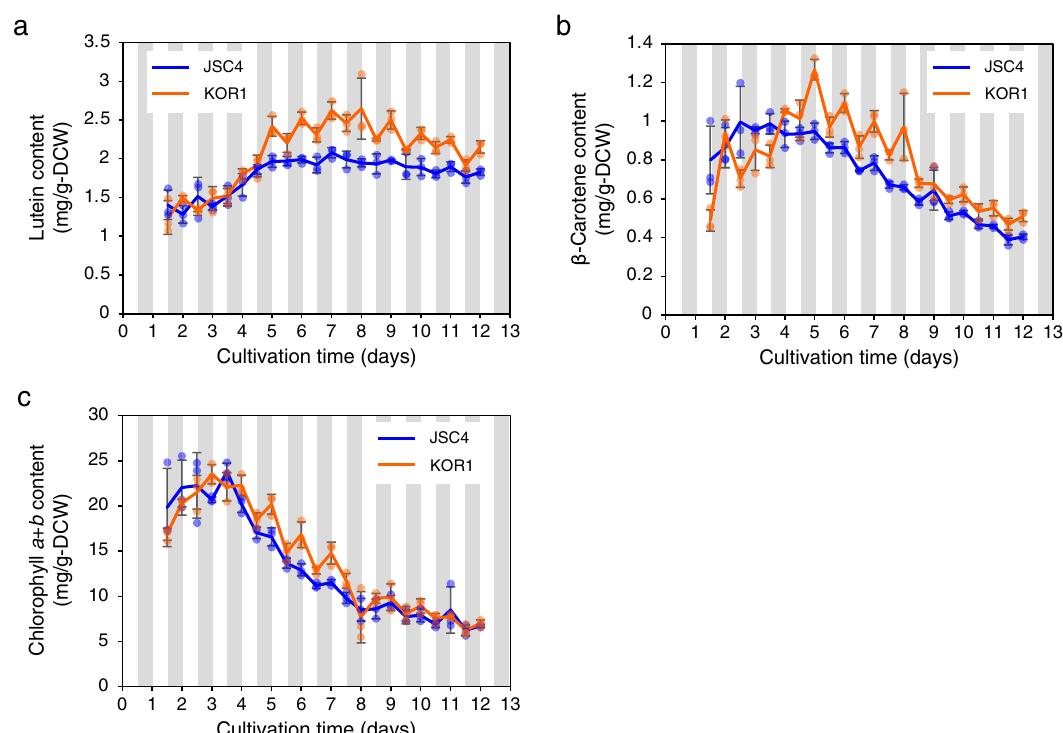
Fig. 4 Time-course pro fi les of photosynthetic pigments. a Lutein content. b β -Carotene content. c Chlorophyll a + b content. White and gray bands represent light and dark periods, respectively. Error bars indicate the standard deviation of three replicate